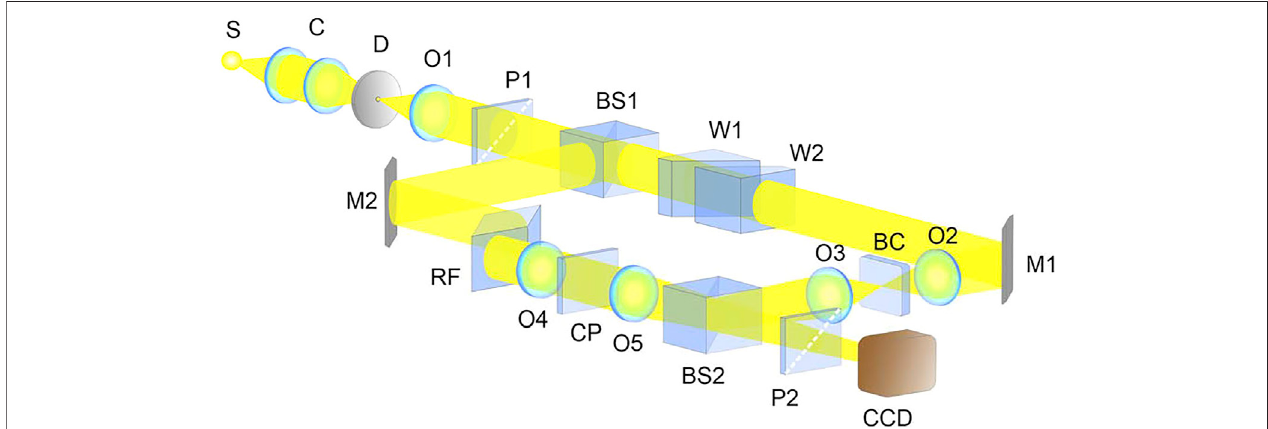
FIGURE1| Experimental arrangementforgenerationofwhite-light opticalvortices:(S)white-lightsource;(C)condenser;(D)diaphragm;(O1, O2,O3,O4,andO5) objective lenses; (P1 and P2) polarizer and analyzer; (BS1 and BS2) beam-splitting cubes; (M1 and M2) mirrors; (BC) singularity-generating object; (CP) compensating plate; (RF) Fresnel rhombus; (W1 and W2) moving and stationary optical wedges; (CCD) camera.